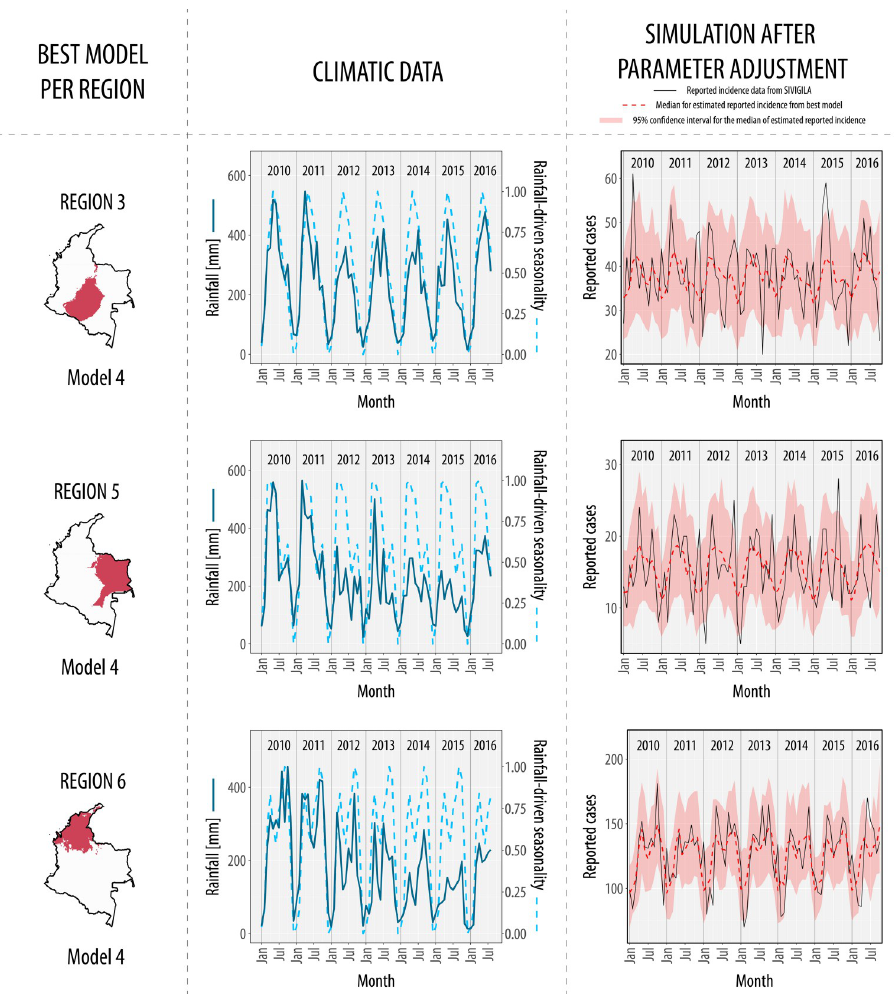
Fig 4. Best models in regions where rainfall drives snakebite incidence. Rainfall modulates snakebite incidence in three regions of the country, region 3, region 5, and region 6. For all regions, the best model was Model 4 that includes rainfall-driven seasonality as covariate (Dashed light-blue lines in climatic data). Note how all the medians for the simulations (dashed red lines) have seasonal peaks throughout the years, showing the association between rainfall- driven seasonality and snakebite incidence. Also, it is evident how incidence in region 6 is significantly higher than in the other regions. Base map of national boundaries of Colombia was obtained from DIVA-GIS free spatial data